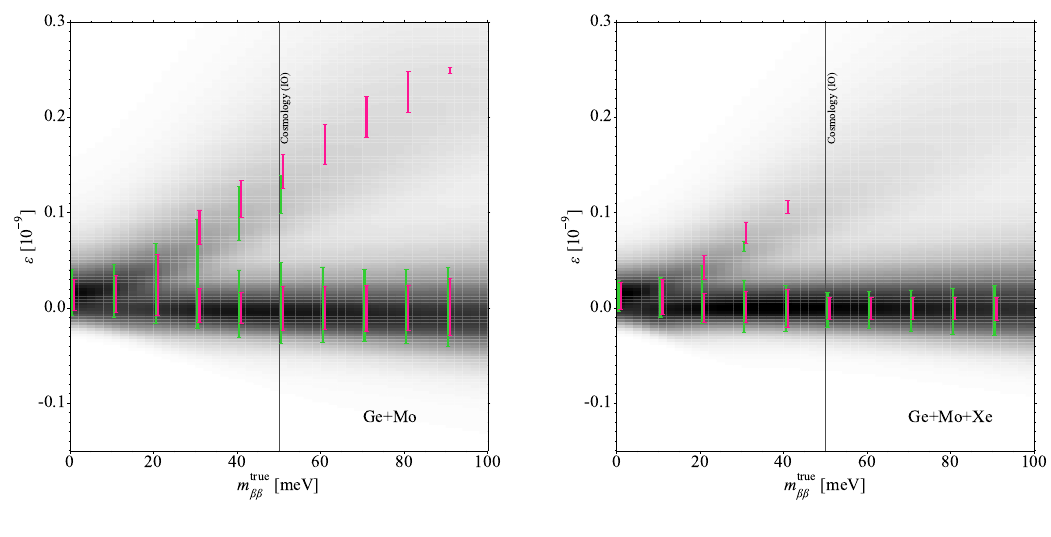
Figure 7 . As figure 6, but marginalized over (cid:15)